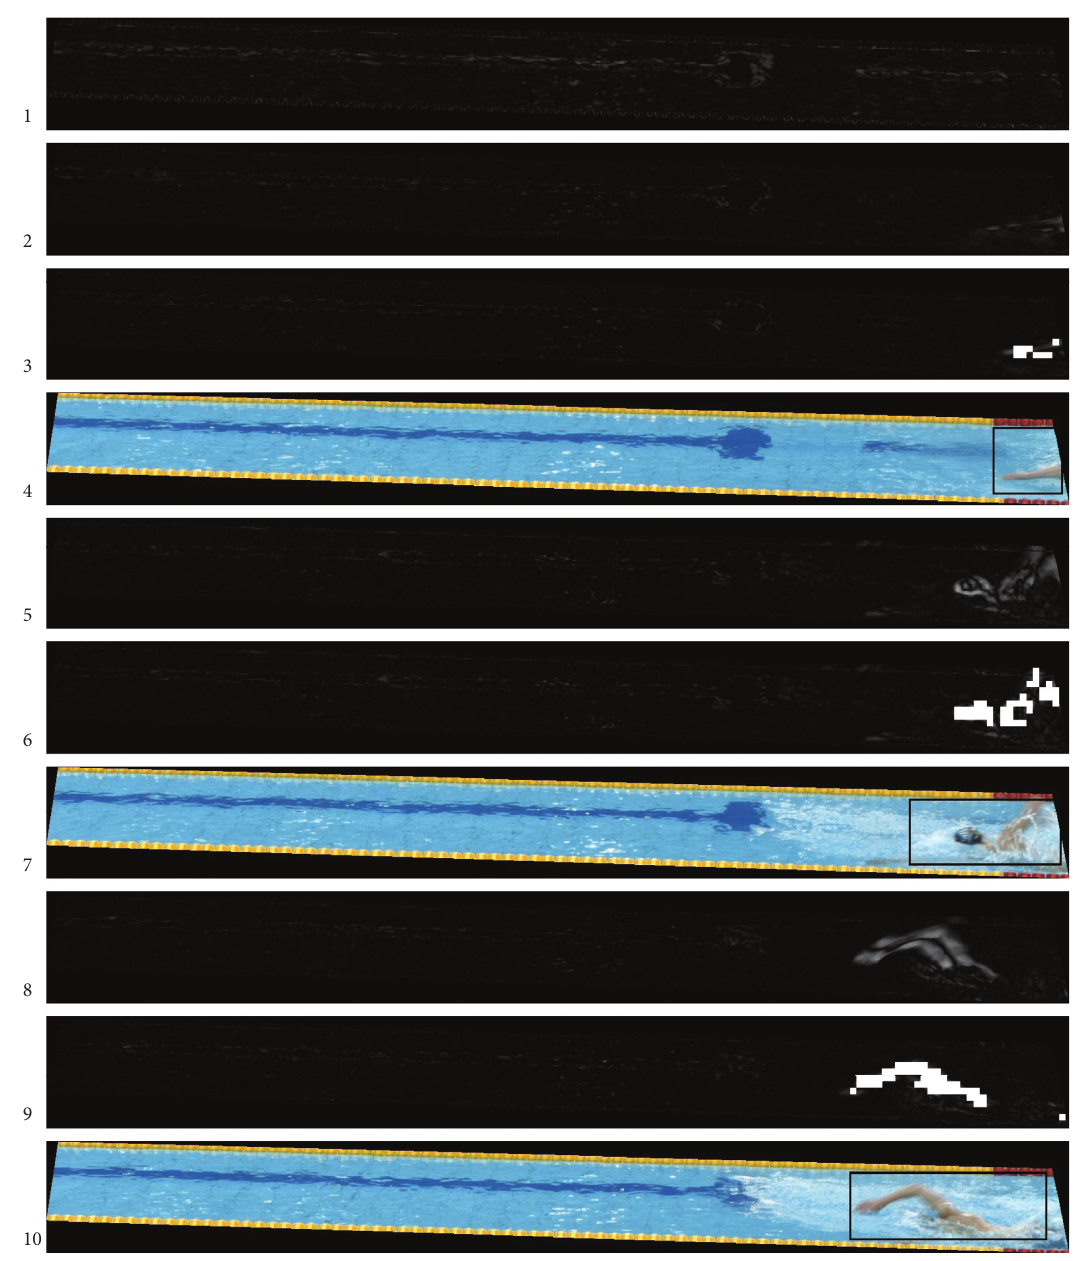
Figure 10: Localization of the region of interest based on the method a contrario . Image 1: noise model obtained from the difference between two images of the empty lane. Images 2, 5, and 8: frame difference between two successive frames. Images 3, 6, and 9: blocs decomposition and thresholding compared to a threshold relative to the noise model. Images 4, 7, and 10: swimmer localization. Swimming Championships in Limoges, France, April